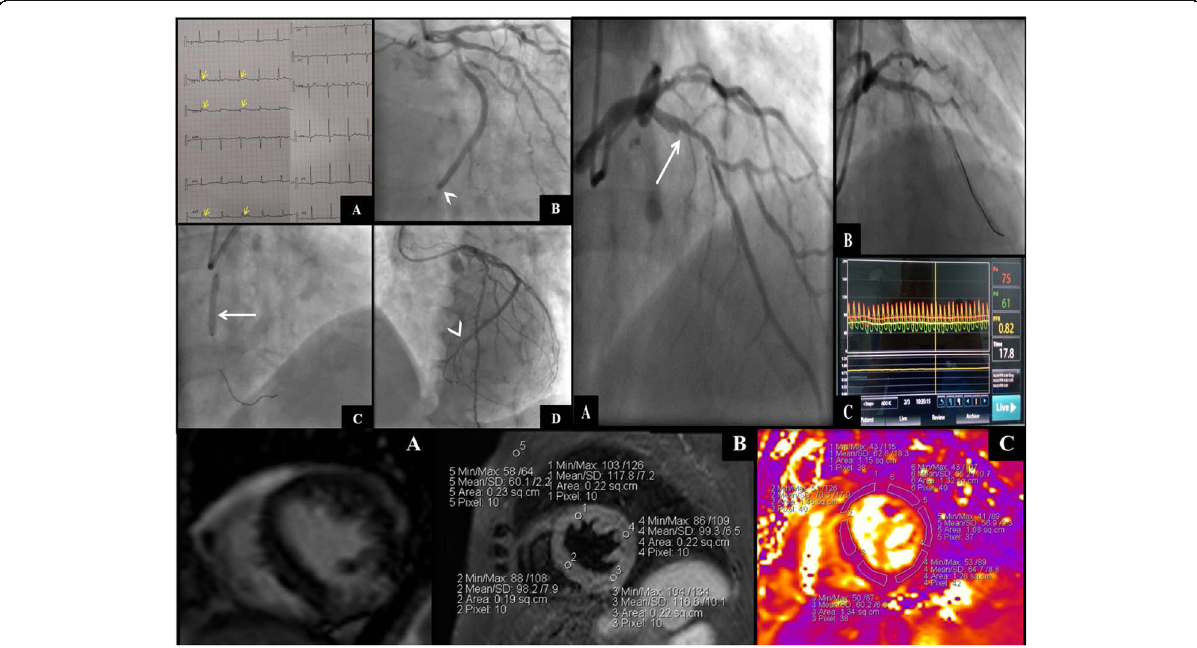
Fig. 4 Left upper panel, ECG ( a ): ST segment elevation in inferior leads (II, III, aVF) (arrows) with reciprocal depression in leads I and aVL. Coronary angiography ( b ): showed culprit lesion in the proximal circumflex artery (LCx) (arrow head). c and d 1ry percutaneous coronary intervention (PCI) to the culprit lesion in LCx. Right upper panel A, Left anterior descending coronary artery (LAD) angiography of same patient showed proximal ulcerative lesion (arrow) causing moderate stenosis (50 ‑ 60% diameter reduction). b and c Fractional flow reserve (FFR) wire in mid LAD to assess its functional significance. Lower row, late gadolinium enhancement short axis views ( a ) showed inferior wall acute infarction. The corresponding turbo inversion magnitude ( b ) was confusing in detection of the myocardial edema, T2 mapping images ( c ) showed edema (> 60 ms) along